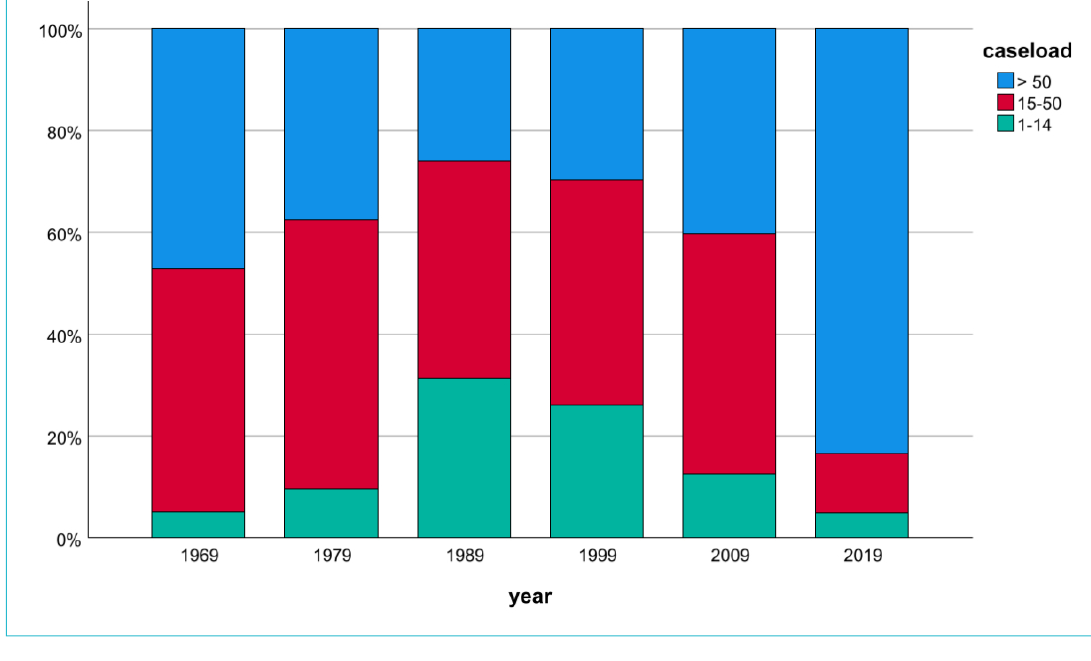
Figure 4: Number of patients with artificial hip joint replacement (total, revision, or hemiprosthesis) operated on by a high (>50), medium (15-50), and low (1-14) volume surgeon per 100 from 1969-2019 at 10-year intervals